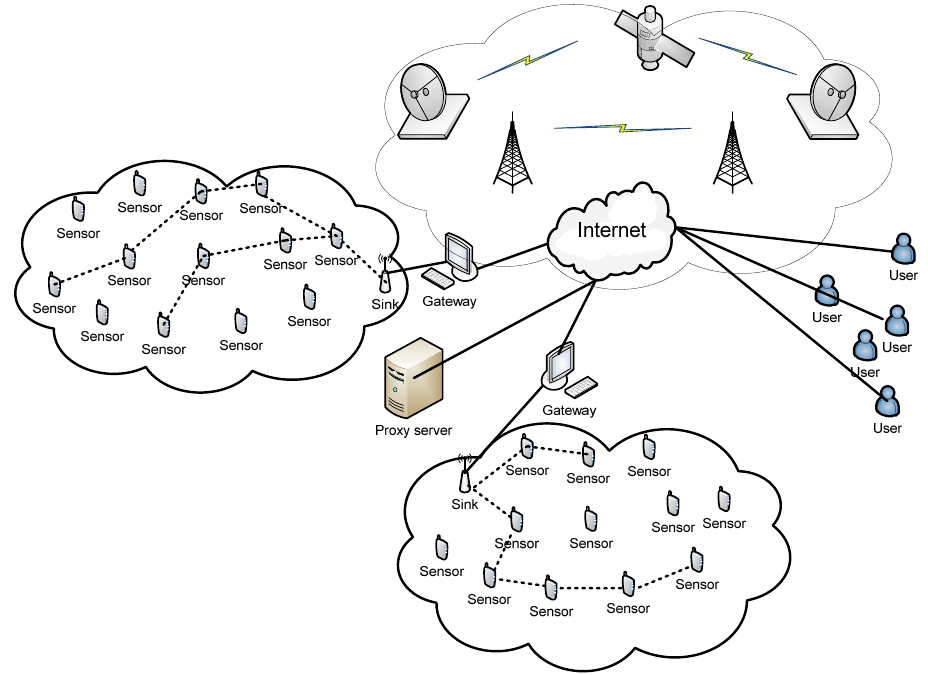
Figure 1. Conventional wireless sensor